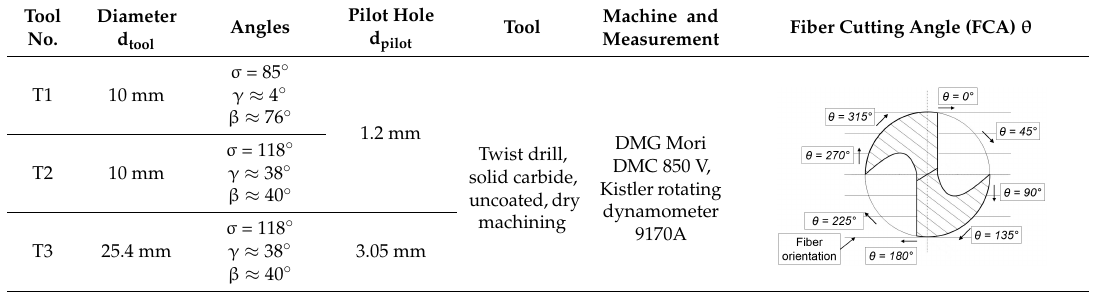
Table 1. Parameters and experimental setup for the test series.